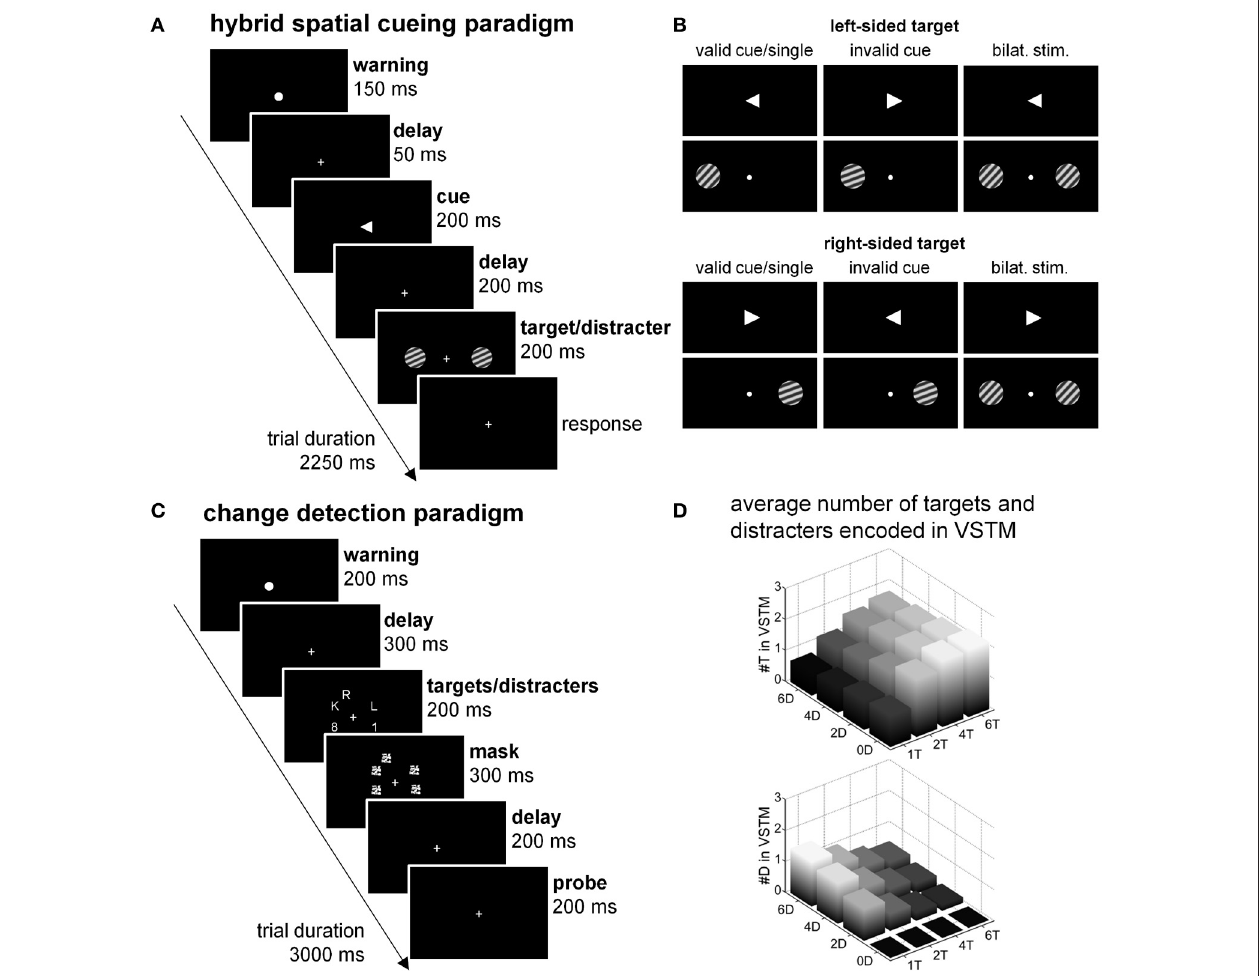
targets) as well as the distracter set size (0, 2, 4, or 6 distracters) according to a factorial design. Letters were targets, numbers distracters. (D) Factorial design with varying targets (T) and distracters (D) within the array. The height of the bars corresponds to the number of targets (#T in VSTM) and the number of distracters (#D in VSTM) loaded into visual short-term memory (VSTM) in each of the cells of the factorial design, according to the Theory of Visual